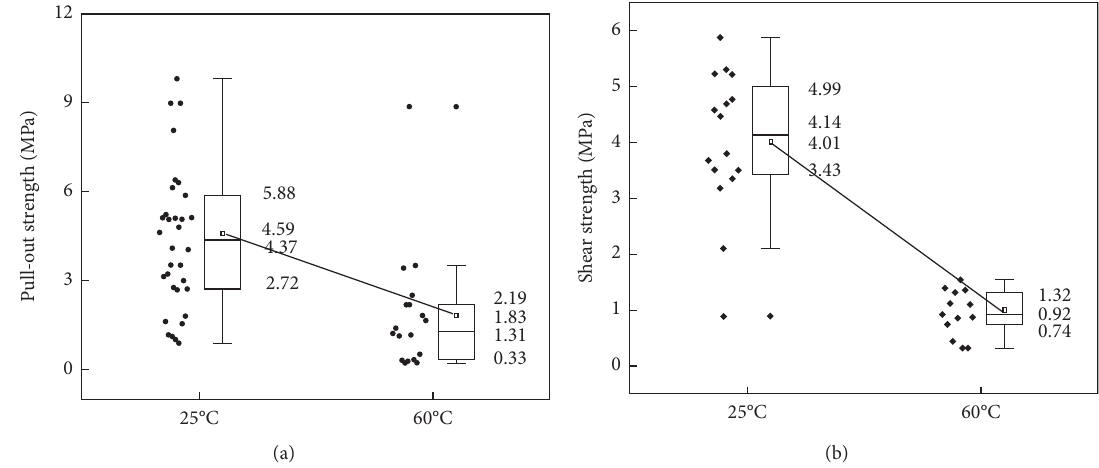
Figure 11: Bonding properties of epoxy resin waterproof adhesive layer: (a) pull-out strength; (b) shear